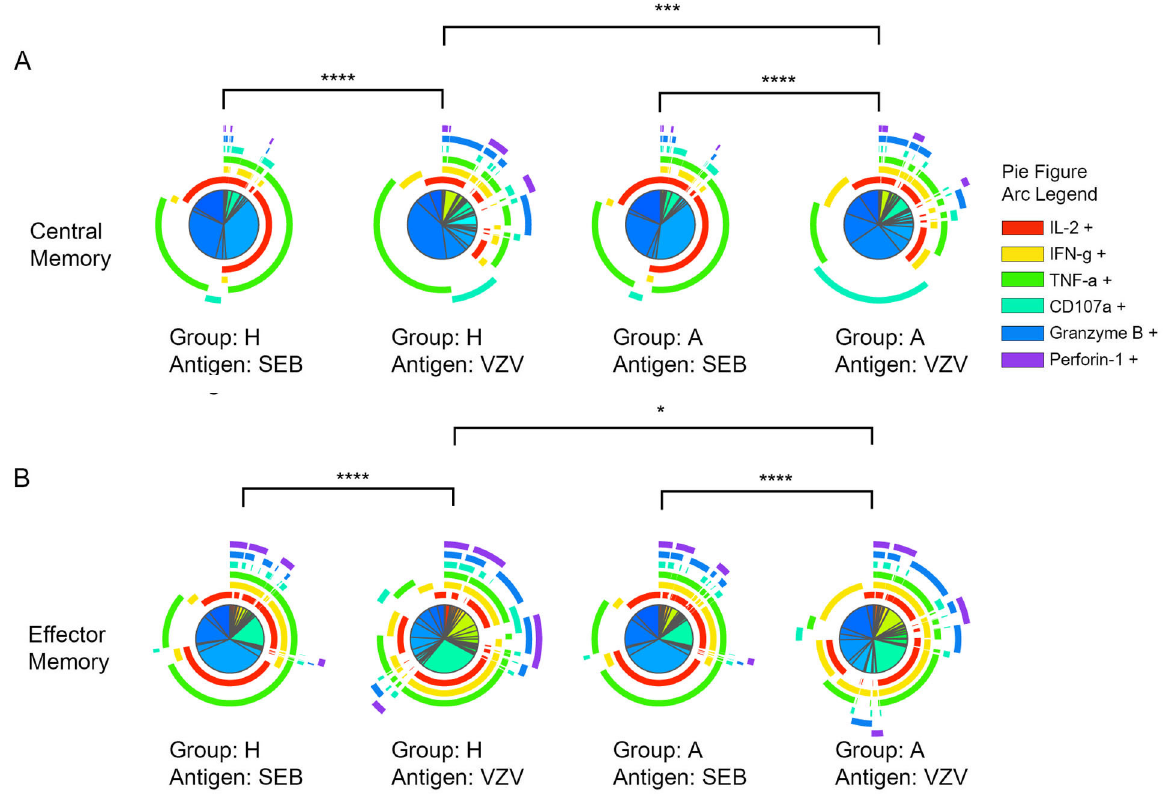
Figure 2. Significant polyfunction differences of central and effector memory CD4+ T cells elicited by SEB or VZV in different groups of individuals. The pie charts represent different combinations of cytokine and effector molecule expression patterns of (A) central memory CD4+ T cells; (B) effector memory CD4+ T cells. The arcs are color coded for each effector function with the color legend noted. (*: P <0.05; **: P <0.01; ***: P <0.001) against SEB or VZV in acute HZ (A) and prior HZ (H)